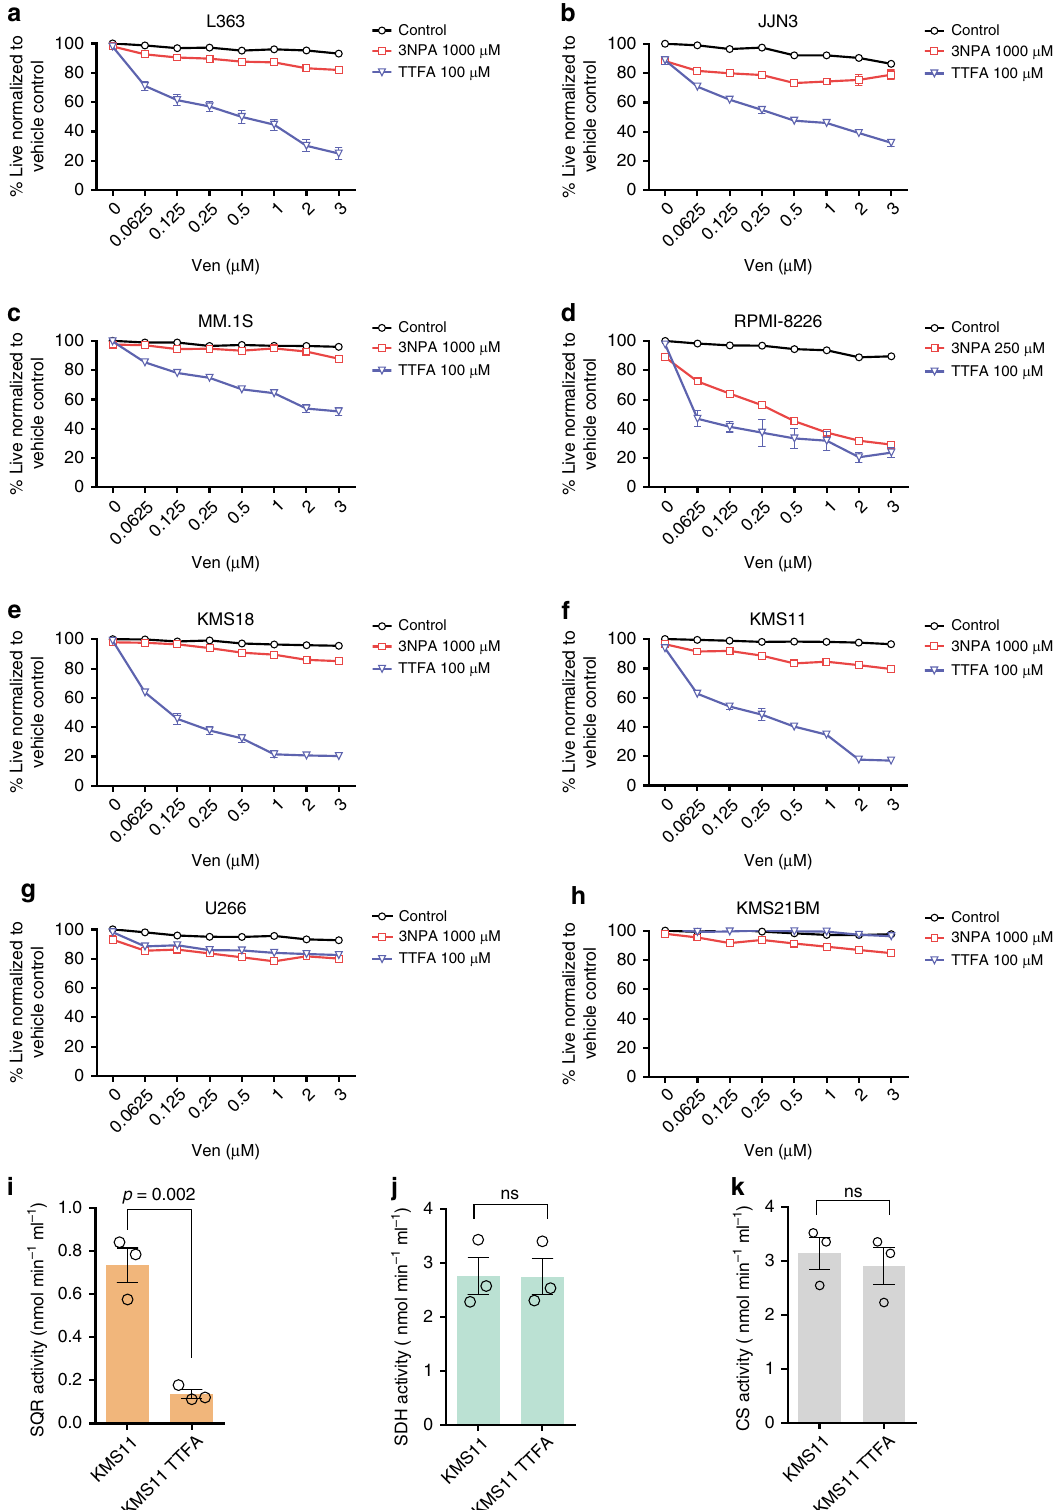
Fig. 3 Inhibition of SQR with Qp site inhibitor TTFA effectively sensitizes resistant MM to venetoclax. a − h SQR inhibition with TTFA (100 μ M) sensitizes indicated myeloma cell lines to venetoclax more effectively than inhibition of SDHA with 3-NPA (1000 μ M except for RPMI-8226 treated with 250 μ M) upon cotreatment with indicated doses of venetoclax for 24 h. Cell viability assessed by AnnexinV/DAPI staining. n = 3 independent experiments. Data are presented as mean values ± SEM. i SQR, j SDH and k CS activities were evaluated demonstrating selective inhibition of SQR activity upon 24 h TTFA treatment. Data are presented as mean values± SEM. p values are calculated using a two-tailed unpaired Student ’ s t test. Data presented are from an n = 3 ± SEM. Source data are provided as a source data fi